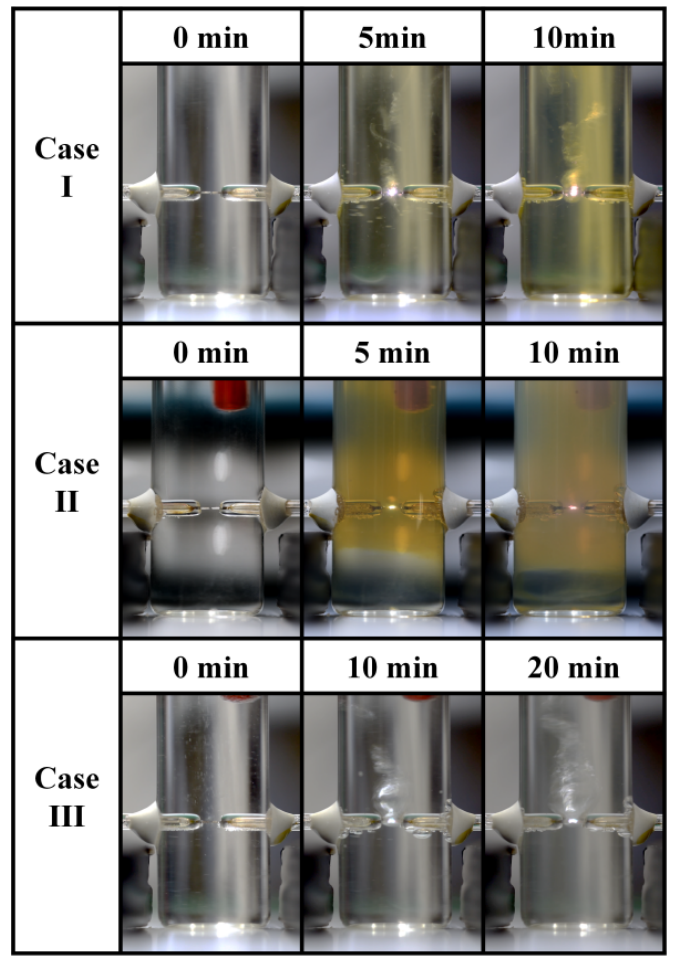
Figure 7. Color changes of Ag NP suspensions for three different cases according to plasma process time.